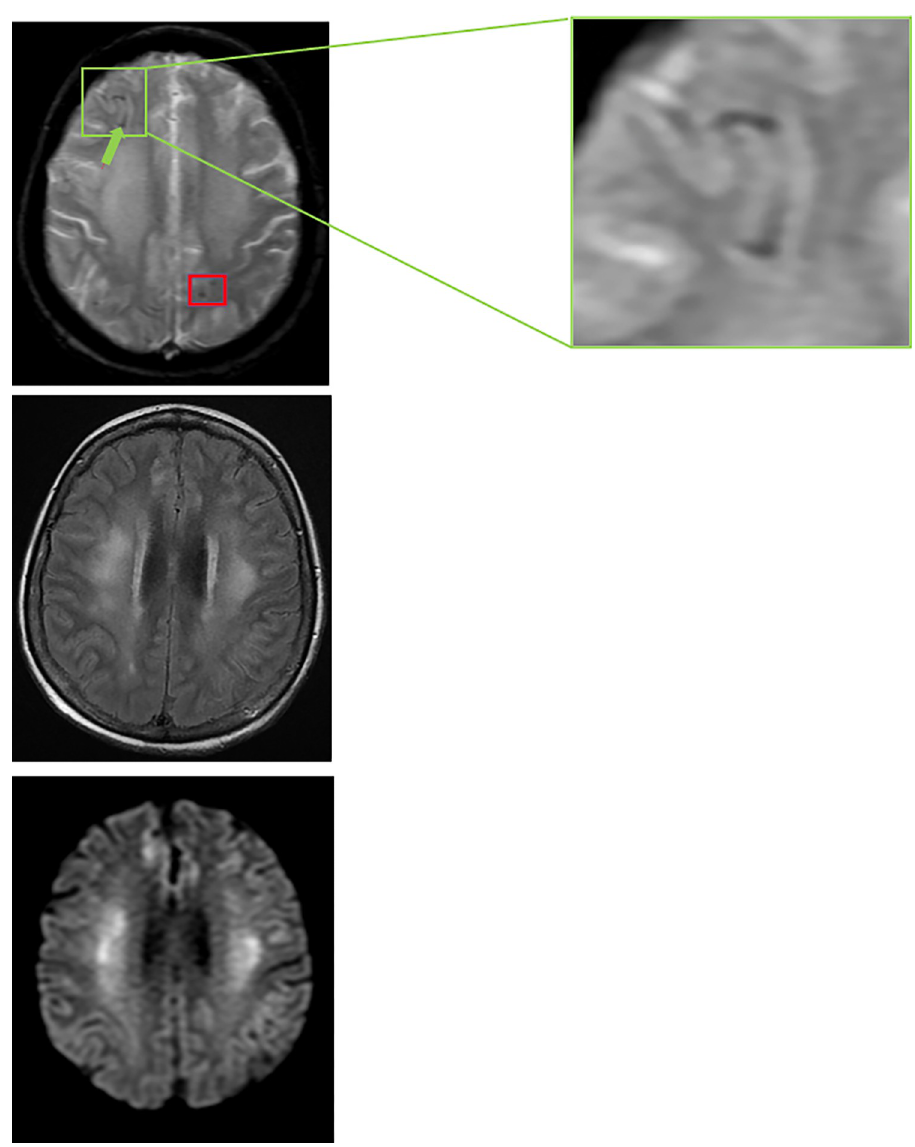
Fig 2. Brain MR images in a 61 y.o. female COVID-19 patient from the non-cancer subgroup who was receiving ventilatory support. Axial gradient echo image shows right frontal subarachnoid hemorrhage (green arrow with enlarged inset showing curvilinear dark signal) and stippled/punctate foci of low signal reflecting left parietal parenchymal microhemorrhage (red box). Bilateral symmetric hyperintensities in the cerebral white matter consistent with encephalitis-like pattern are shown in the axial FLAIR (middle) and DWI (bottom) images.